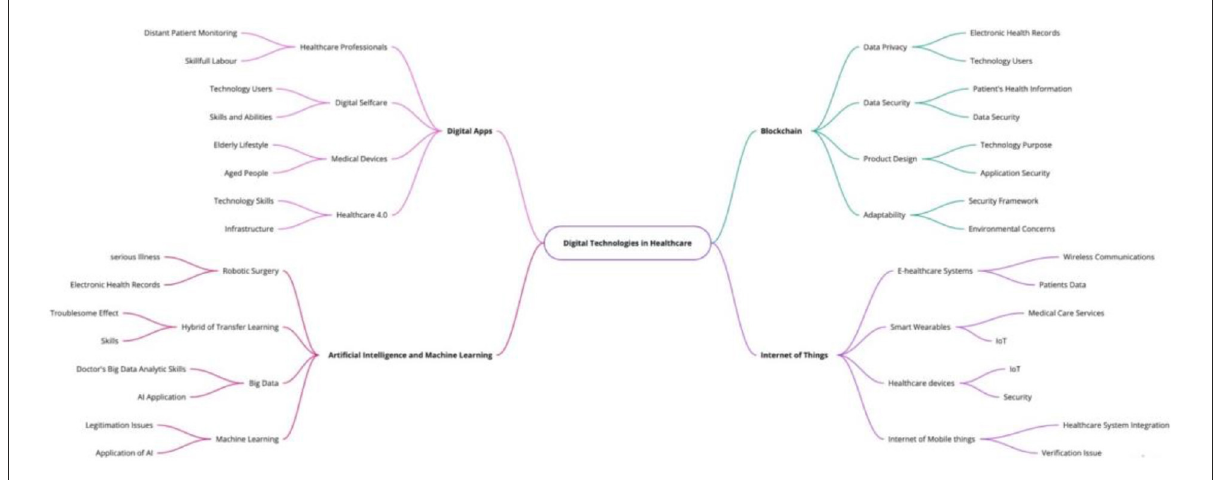
FIGURE5 Mapping of literature on technologies in